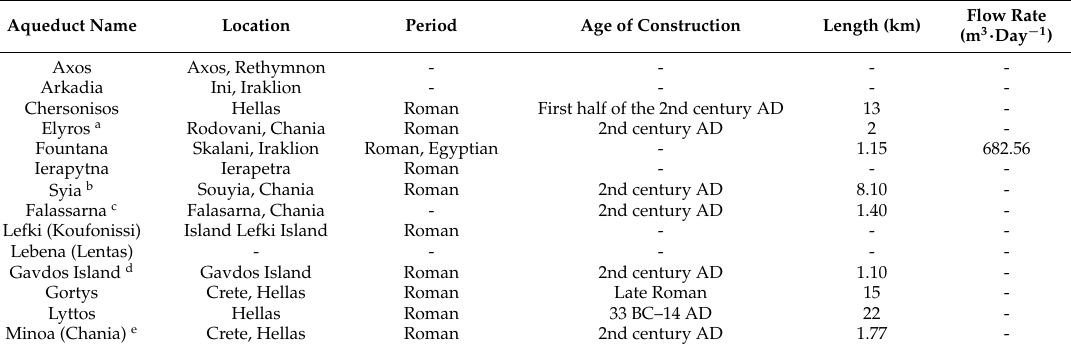
Table 4. Characteristics of a selected of Roman aqueducts (adapted from [10,37,38]).